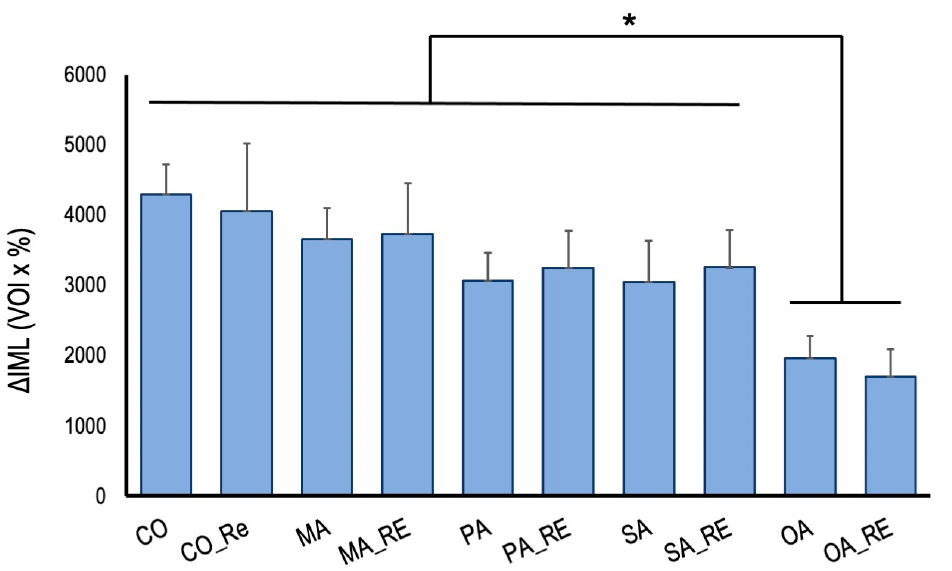
Figure 7. TMR images of each group before and after pH-cycling. ( a ) Deionized distilled water wash, ( b ) remineralization solution wash. The increase in Δ IML after pH cycling is shown in Figure 8.